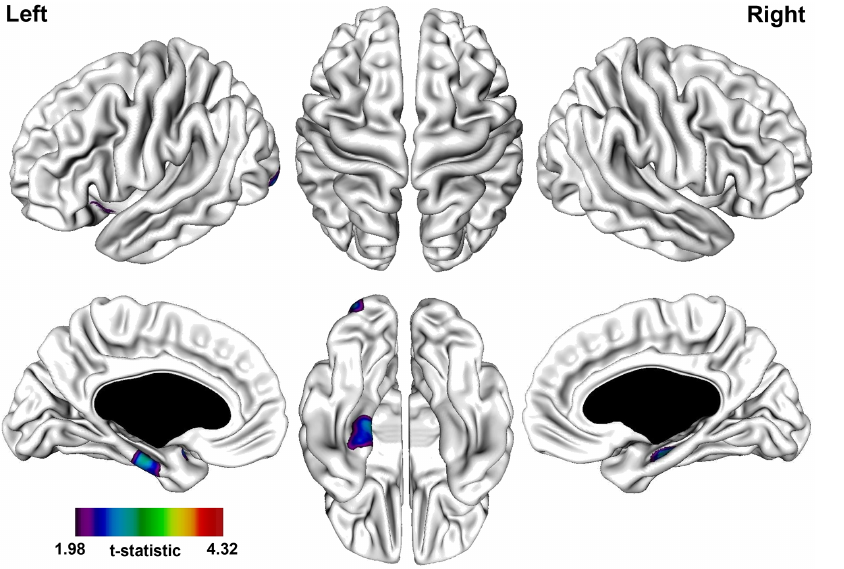
Figure 3. t-statistical brain maps showing cortical thinning in patients without persistent negative symptoms compared to healthy controls. Most pronounced difference in the parahippocampal gyrus bi-laterally. The colour bar indicates the t-value. All areas shown exceed a FDR corrected statistical threshold of P , 0.01.